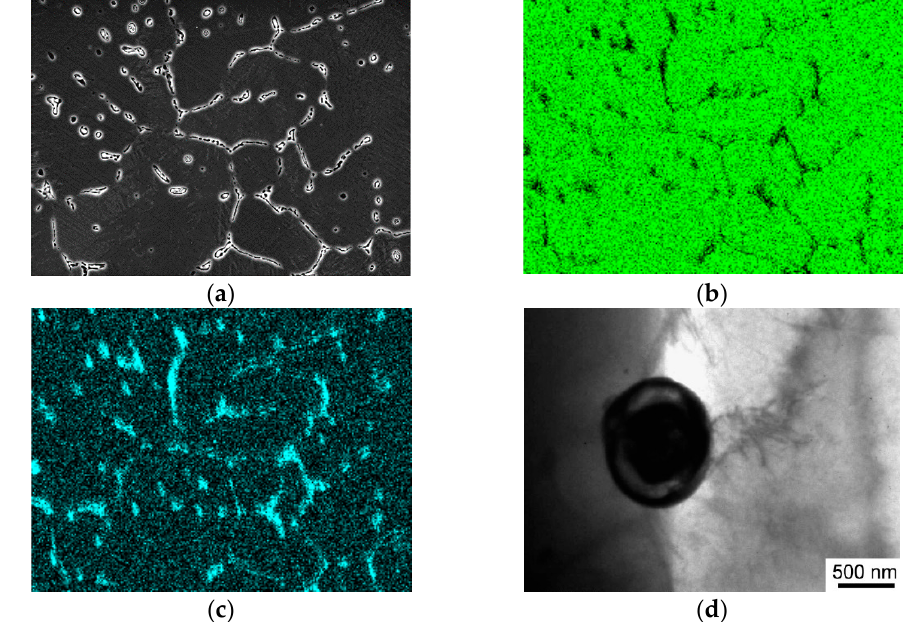
Figure 10. Microstructure of the Mg ‐ 1%Ca alloy in the homogenized state and elemental mapping of the alloy’s microstructure: ( a ) typical structure (SEM); ( b , c ) elemental mapping of the microstruc ‐ ture: distribution of the chemical elements Mg ( b ) and Ca ( c ); ( d ) Mg 2 Ca particle of a globular shape with the corresponding diffraction pattern in the insert (TEM).